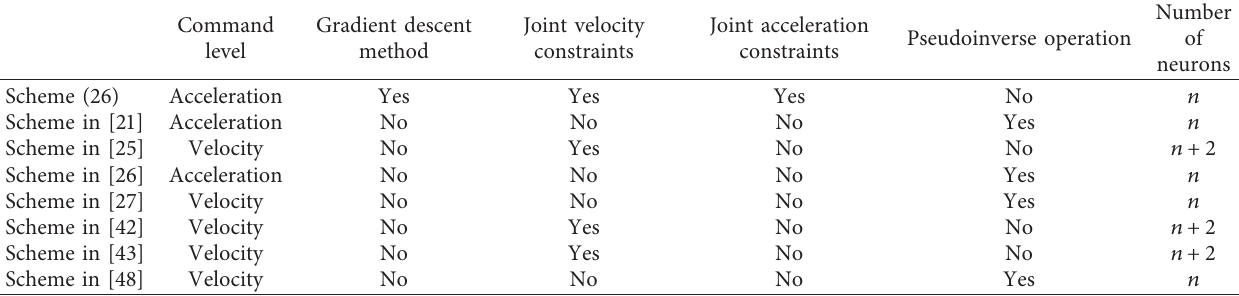
Table 1: Comparisons among different approaches for visual servoing of redundant